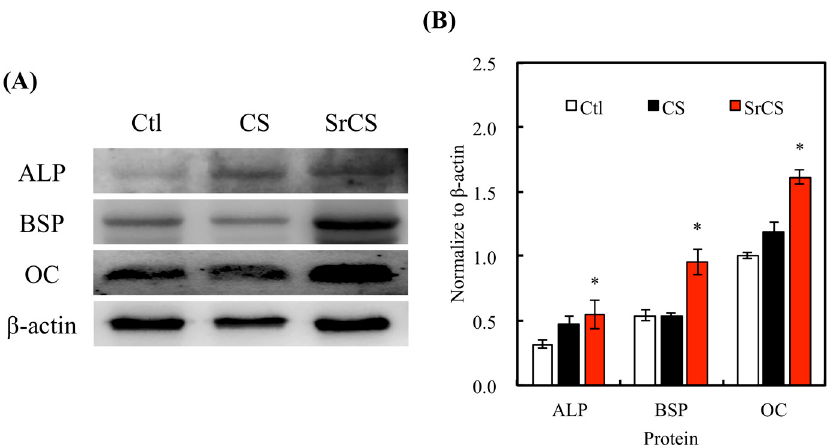
Figure 10. ( A ) The expression levels of osteogenic-related protein ALP, BSP, and OC protein in MSCs cultured with various scaffolds for 7 days via western blot. ( B ) The quantification of osteogenic-related protein, respectively. Data presented as mean ± SEM, n = 3 for each group. “*” indicates a significant difference ( p < 0.05) when compared to CS scaffold. “Ctl” represented cells that grew in empty wells without any scaffolds.